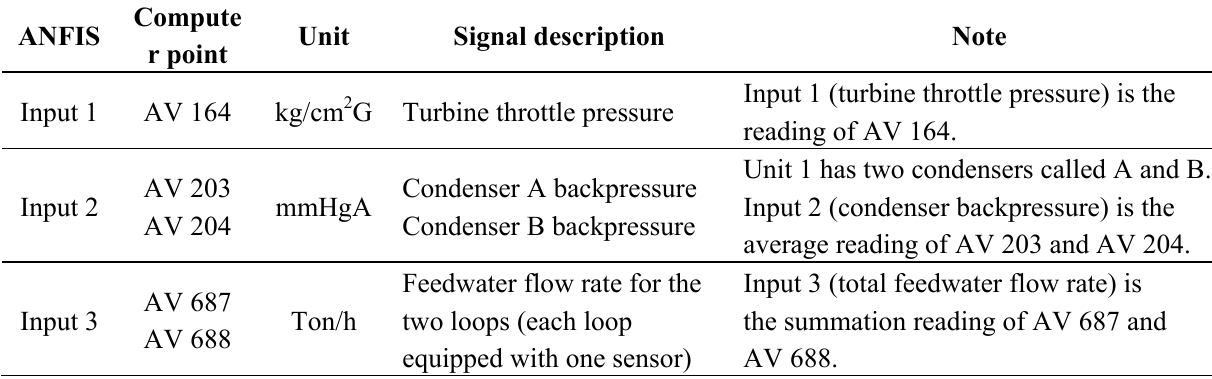
Table 1. Selected operating